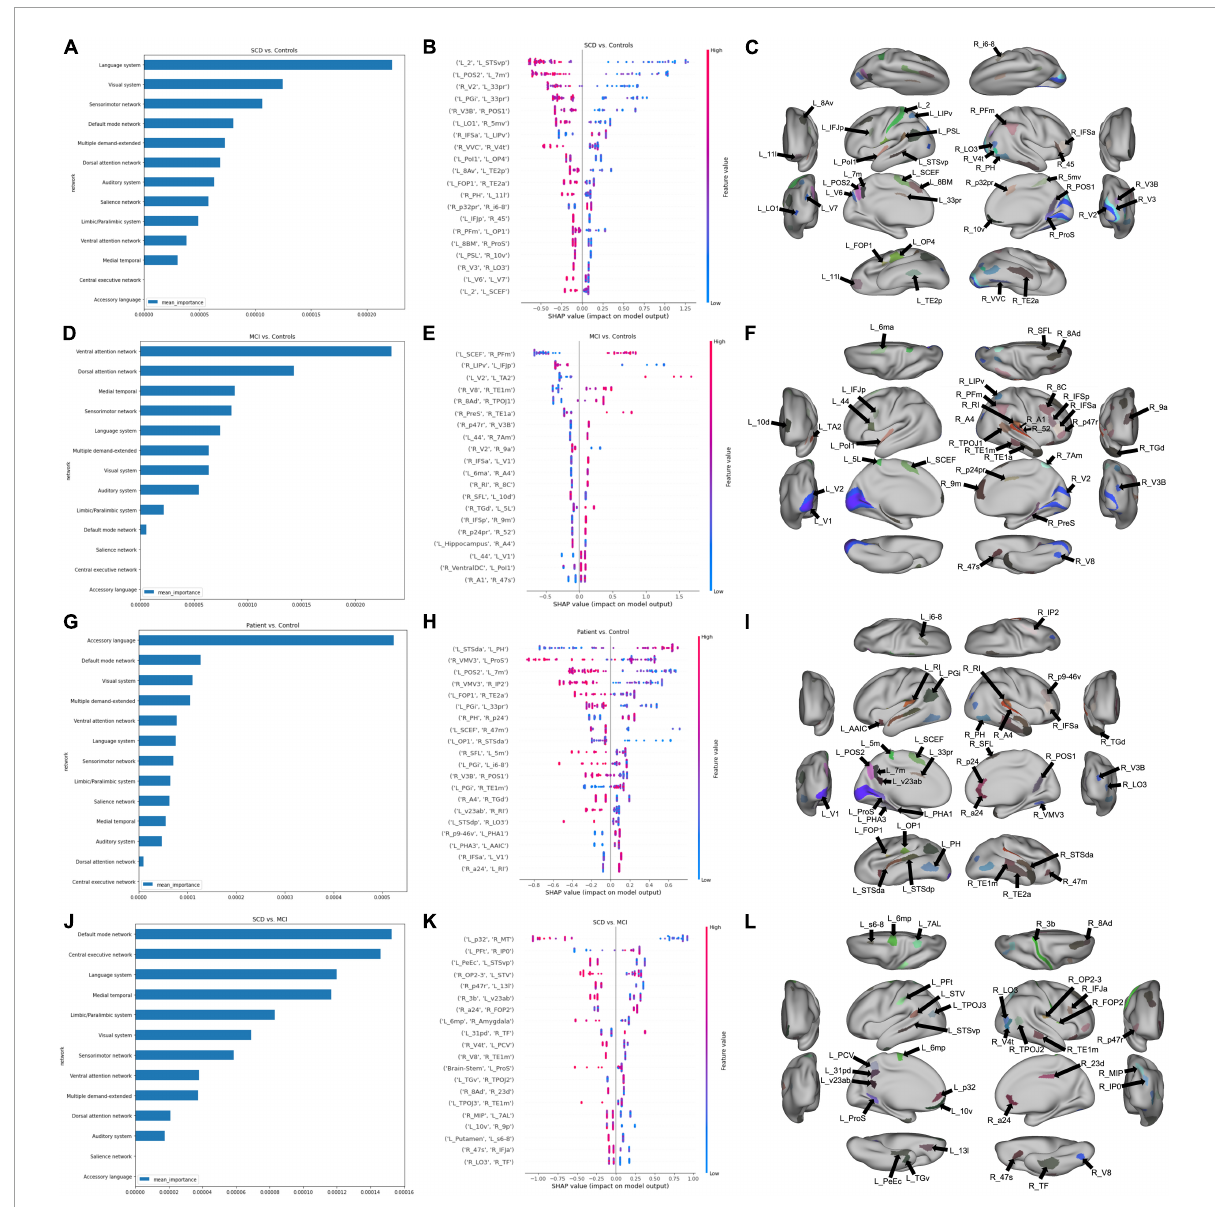
FIGURE1 Features associated with each machine learning model classifying subjects into diagnostic groups. (A) A graph ranking network level features, and (B) a SHAP plot ranking the top 20 parcel-based features when classifying SCD from controls, along with, (C) an anatomical representation of the parcels comprising the top 20 features. (D) Network level graph, (E) SHAP plot, and (F) anatomical representation for the model classifying MCI and controls. (G) Network level graph, (H) SHAP plot, and (I) anatomical representation for the model classifying the combined SCD and MCI cohort, and controls. (J) Network level graph, (K) SHAP plot, and (L) anatomical representation for the model classifying SCD and